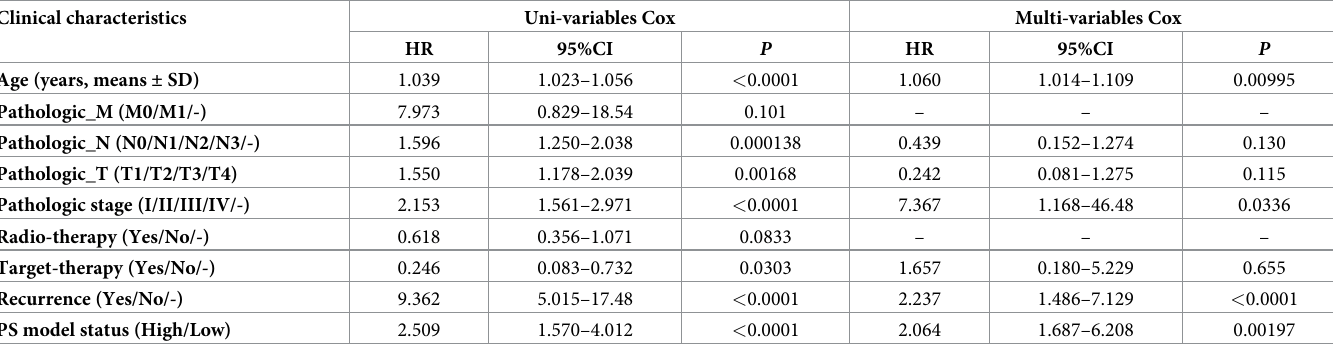
Table 3. Clinical factor screening information